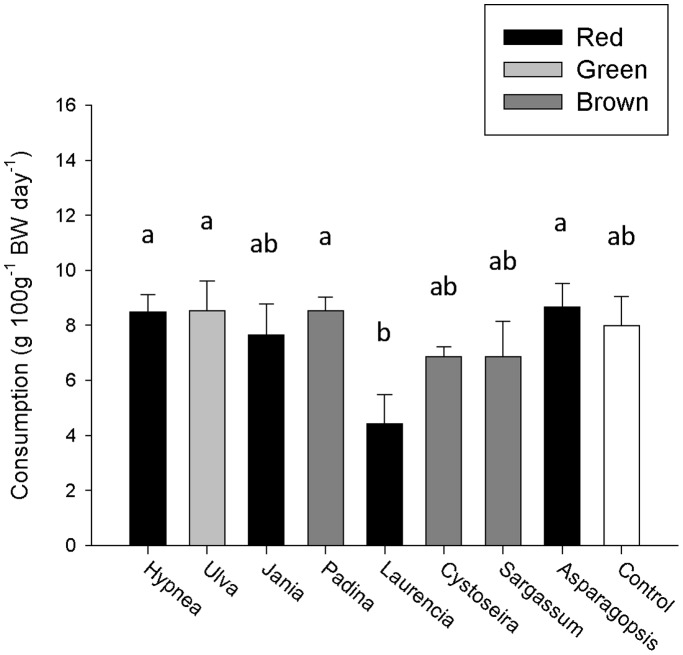
No-choice feeding assay of artificial diets comprised of dried algae and bound by carrageenan.Data show mean (+SE) consumption rates (g FW diet day−1, n = 5) of diets per treatment standardised for abalone size (100g−1 BW). Abalone size ranged from 26–184 g (mean = 89.63 g). Common letters above columns indicate no significant difference (Tukey’s HSD, p>0.05). Control diet (white bar, no algae) was also included in the formal analysis.